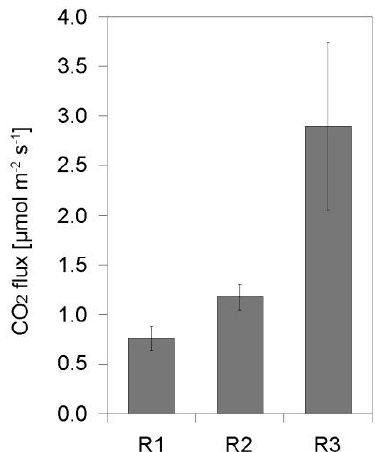
Figure 5. The annual mean CO 2 flux density from the Vistula river measured at three sites located along the river (Figure 1). Error bars denote standard deviation of the mean values.